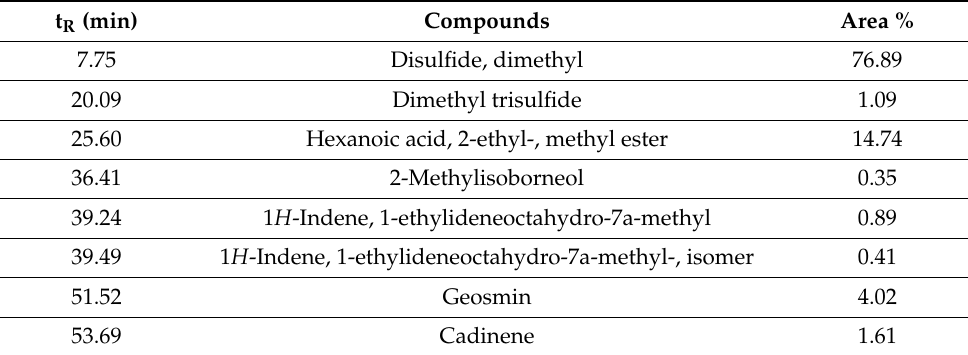
Table 5. VOCs produced by S. violaceoruber identified using SPME-GC/MS.